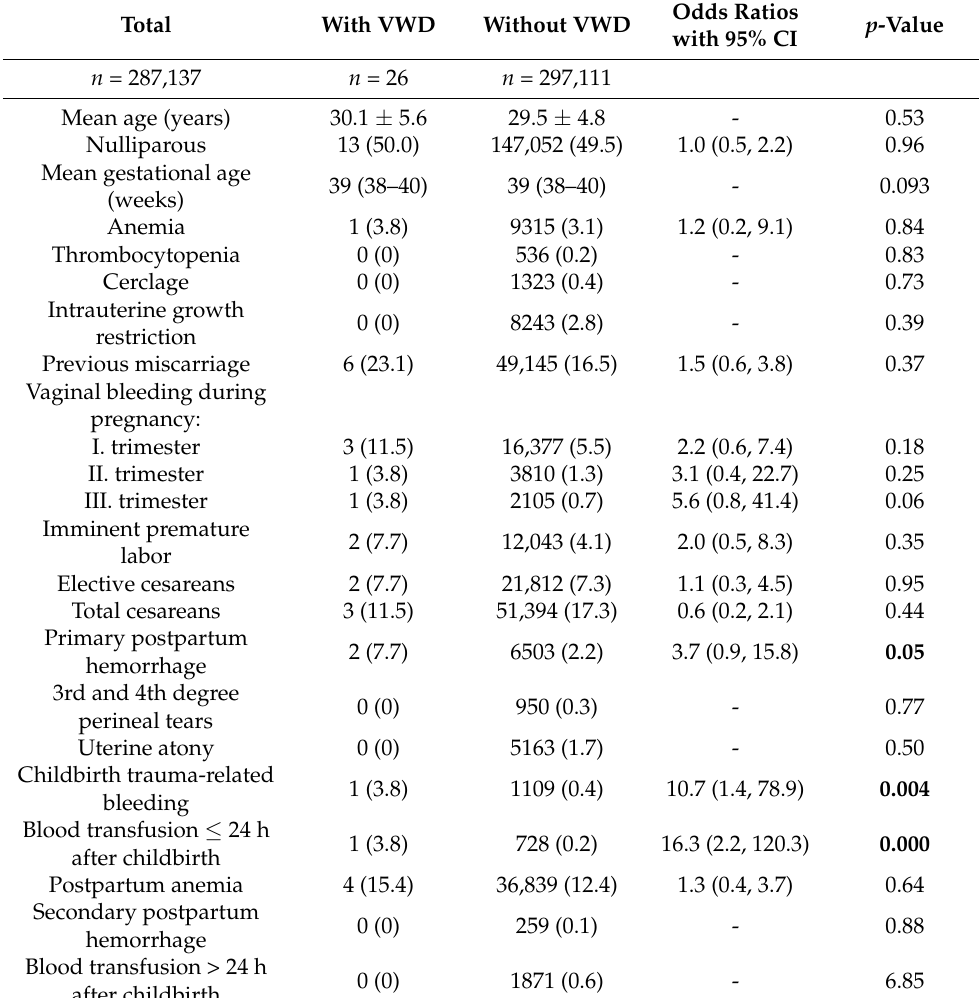
Table 1. Maternal characteristics of pregnancies and the odds of obstetric complications in women with von Willebrand disease (VWD) compared with women without VWD. Total With VWD Without VWD